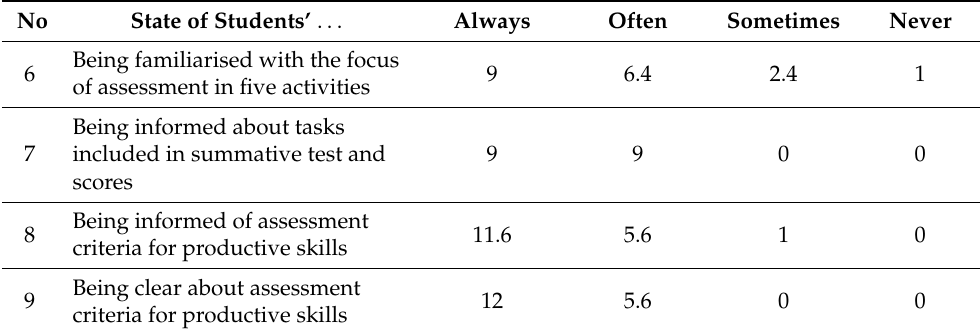
Table 2. State of students’ knowledge about assessment criteria in the GE